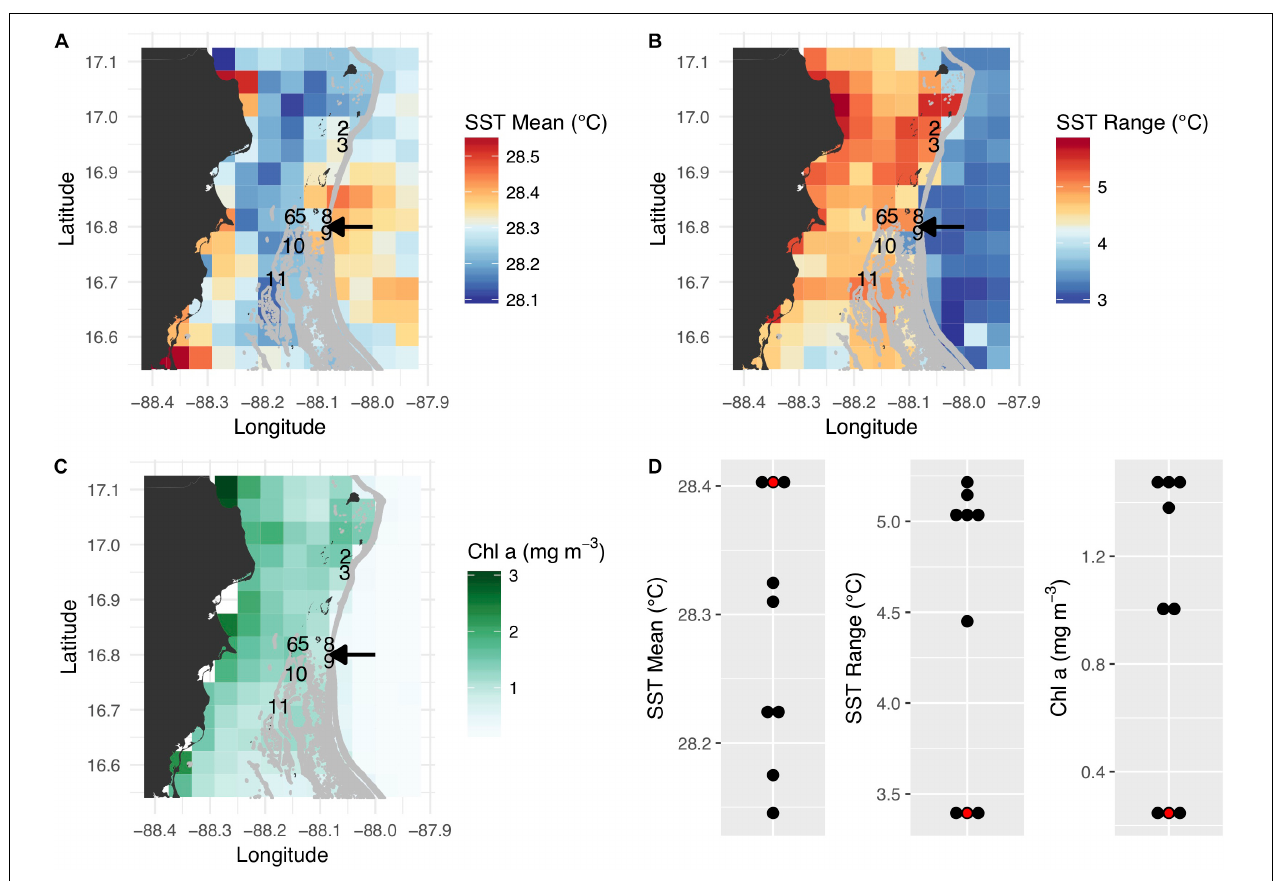
FIGURE 1 | Satellite-derived environmental conditions associated with coral collection sites and the common garden along the Belize Barrier Reef. (A–C) Mean annual sea surface temperature (SST), annual SST range, and annual mean chlorophyll a concentration. The collection sites of the eight analyzed coral colonies are depicted by colony numbers, and the arrows show the location of the common garden (colonies 8 and 9 originated from just north of the common garden site). (D) Summary of native habitat and common garden environmental conditions. The common garden is depicted in